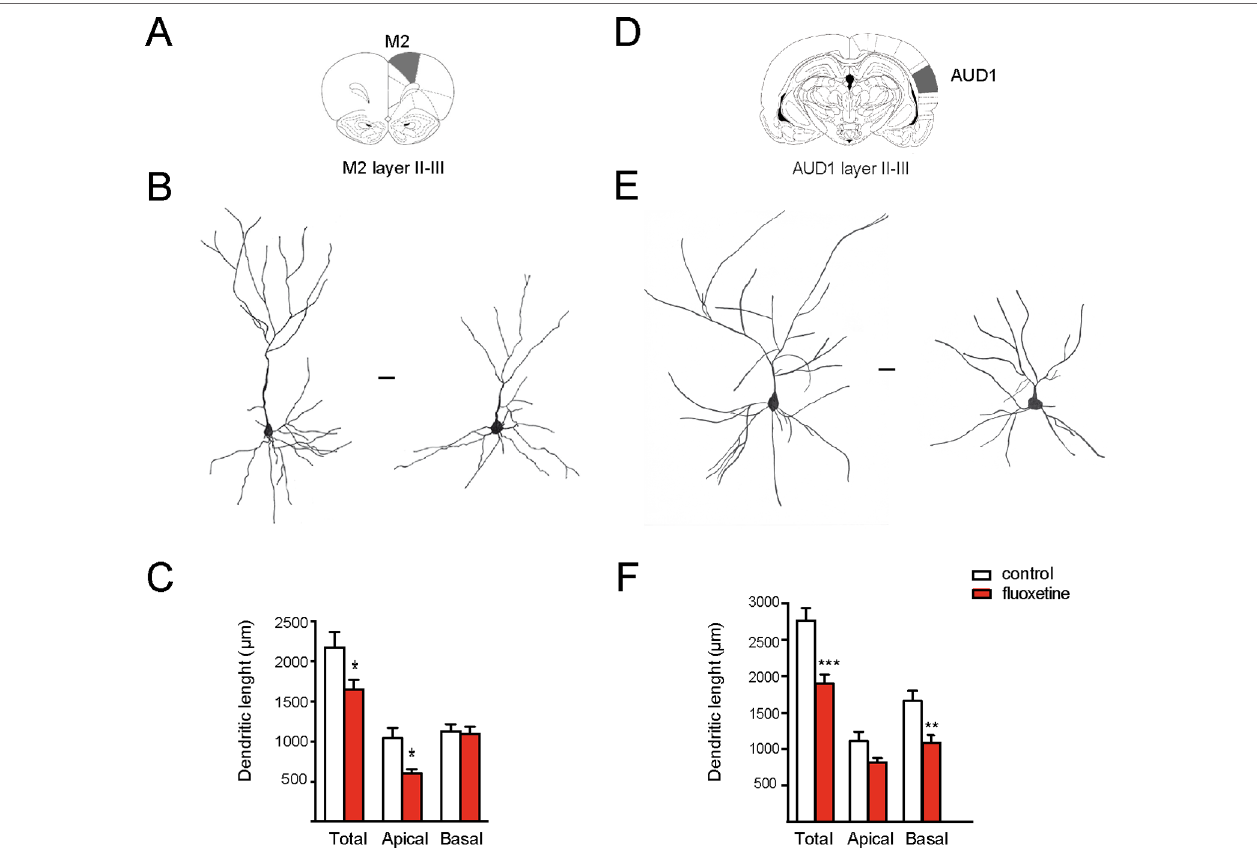
FIGURE 2 | Chronic fluoxetine treatment (28 days) decreased the dendritic length of pyramidal neurons in the motor and auditory cortices (layer II–III). Golgi-stained neurons of the II–III layer of the secondary motor cortex (M2) and the primary auditory cortex (AUD1) were drawn with camera lucida and digitally scanned. (A) and (D) Scheme of the analyzed areas (Paxinos and Watson, 1998). (B) and (E) Representative drawings of neurons obtained from vehicle or fluoxetine-treated animals. In each case, the neuron at the left is from the control (vehicle-treated), while the neuron at the right is from the fluoxetine-treated animal. Scale bar: 20 µm. (C) and (F) Quantifications of the total, apical, and basal dendritic lengths. For each condition, we analyzed at least 10 neurons obtained from three animals per group (in the case of M2) and from three (control) and four (fluoxetine-treated) animals in the case of AUD1. Values represent mean ± SEM. * p ≤ 0.05; ** p < 0.01 *** p < 0.001 Mann–Whitney U